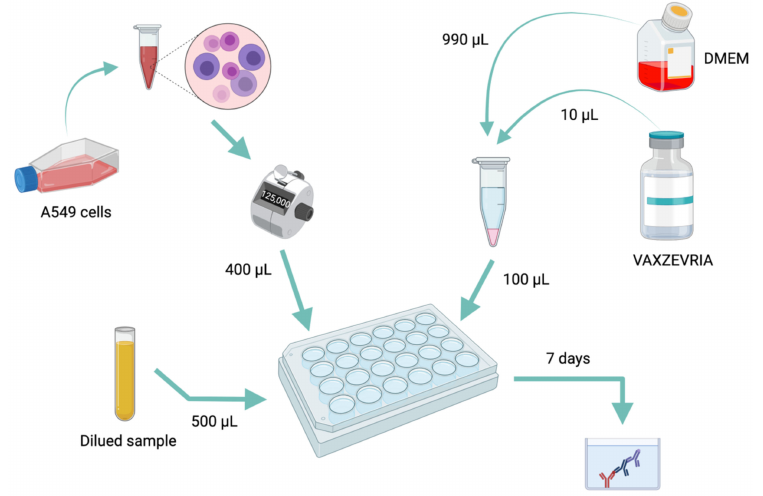
Figure 2. A summary diagram of the handling